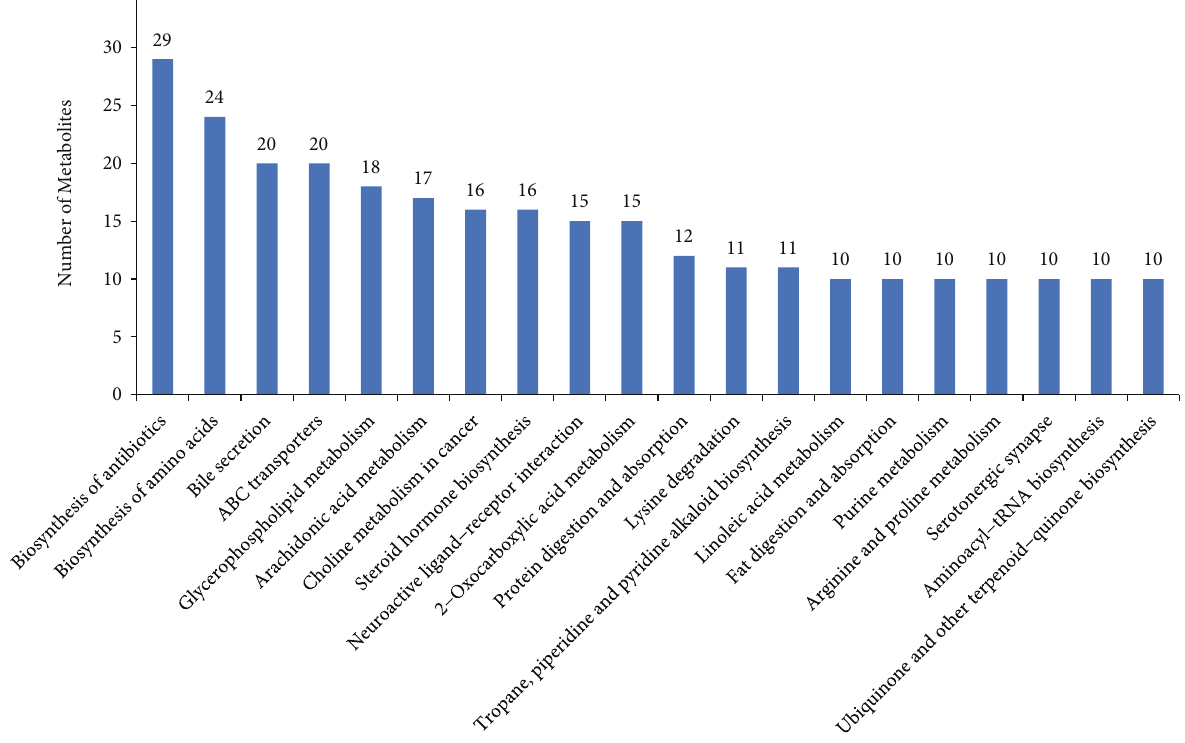
Figure 3: First 20 metabolic pathways in Bacillus